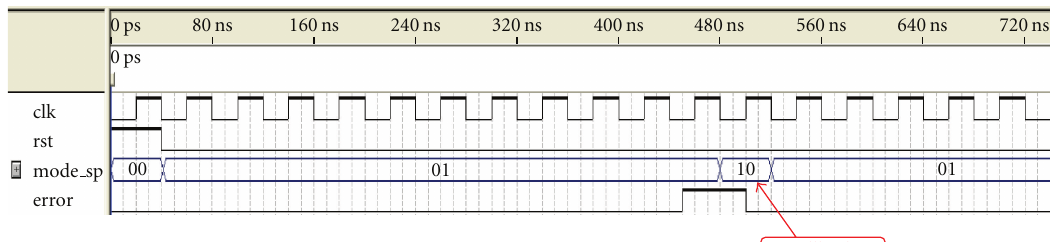
Figure 18: Recoverable error detection.